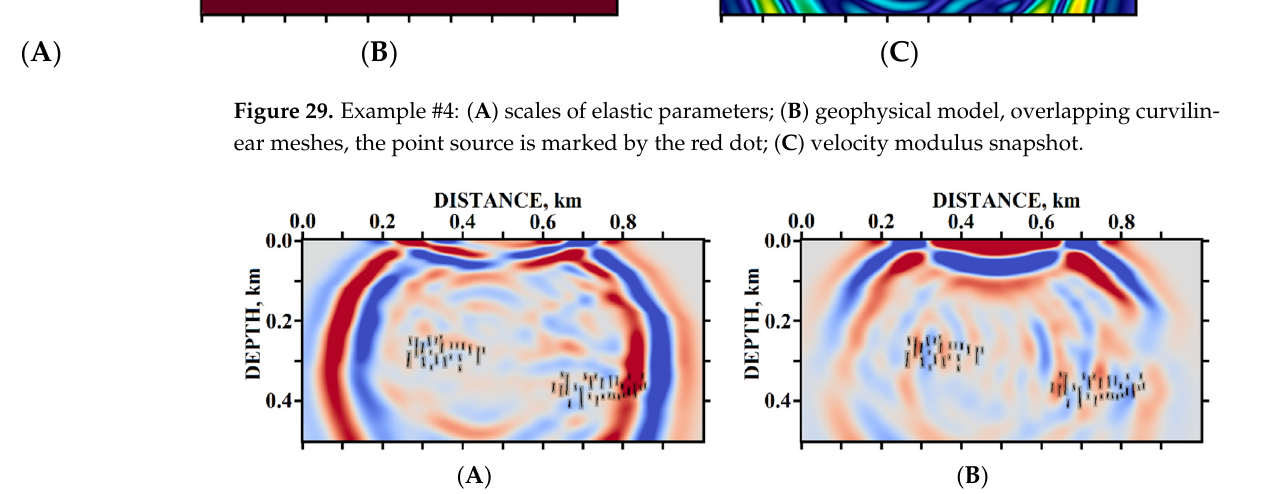
Figure 30. Example #4, snapshots at the time of 0.25 s: ( A ) horizontal component of velocity; ( B ) vertical component of velocity.